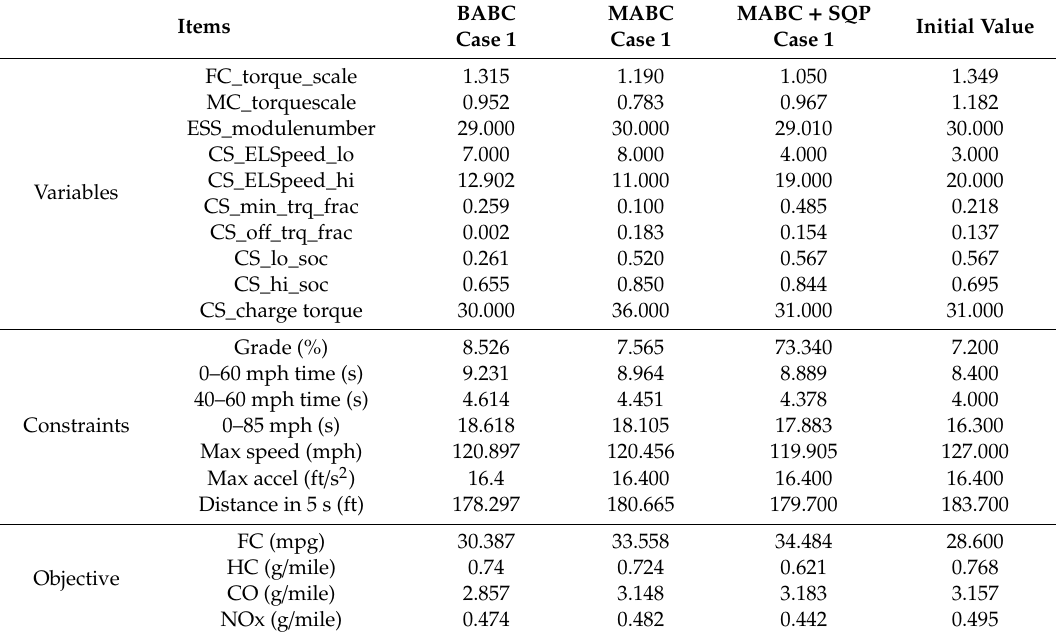
Table 8. Comparison of the ECE EUDC driving cycle for the BABC, MABC, and MABC + SQP methods.